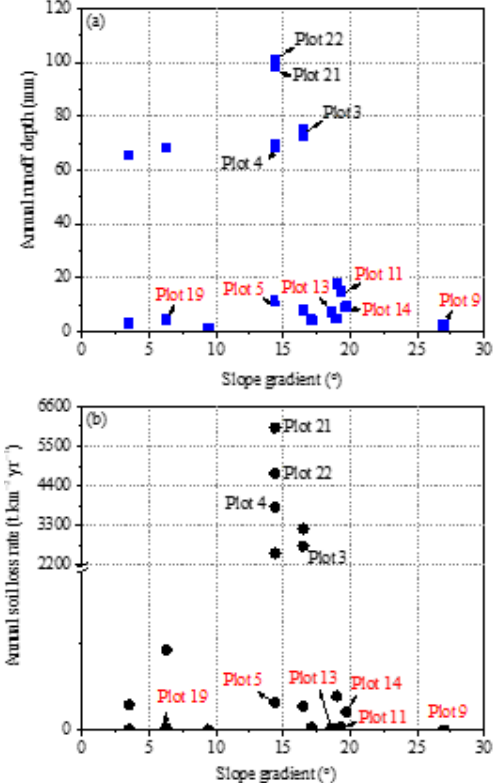
Figure 5. Change patterns of annual runoff depth ( a ) and annual soil loss rate ( b ) with increasing slope degree in 2014–2020 for the 22 runoff plots. Note: the plots in black letters represent bare plots, and those in red letters present shrub plots in Table 1.